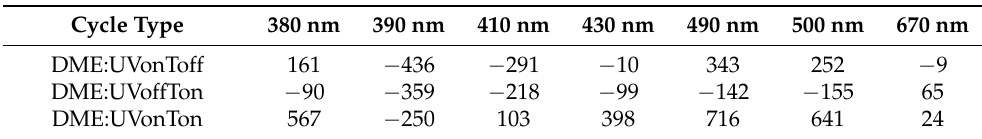
Table 3. Signal shifts S(360s)-S(1800s) obtained during the degradation of regular diesel RDFU(s) during the DME cycle.